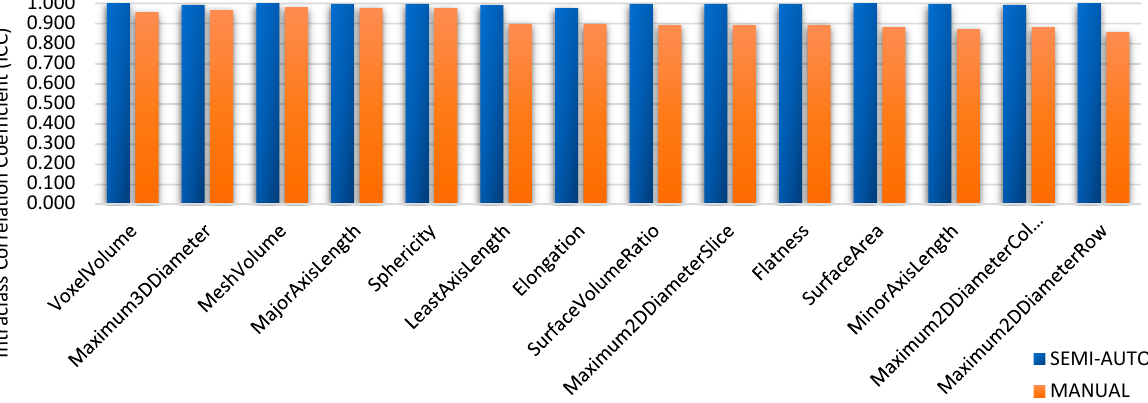
Figure 4. Comparisons of shape-based feature values for the intra-class correlation coefficient (ICC).